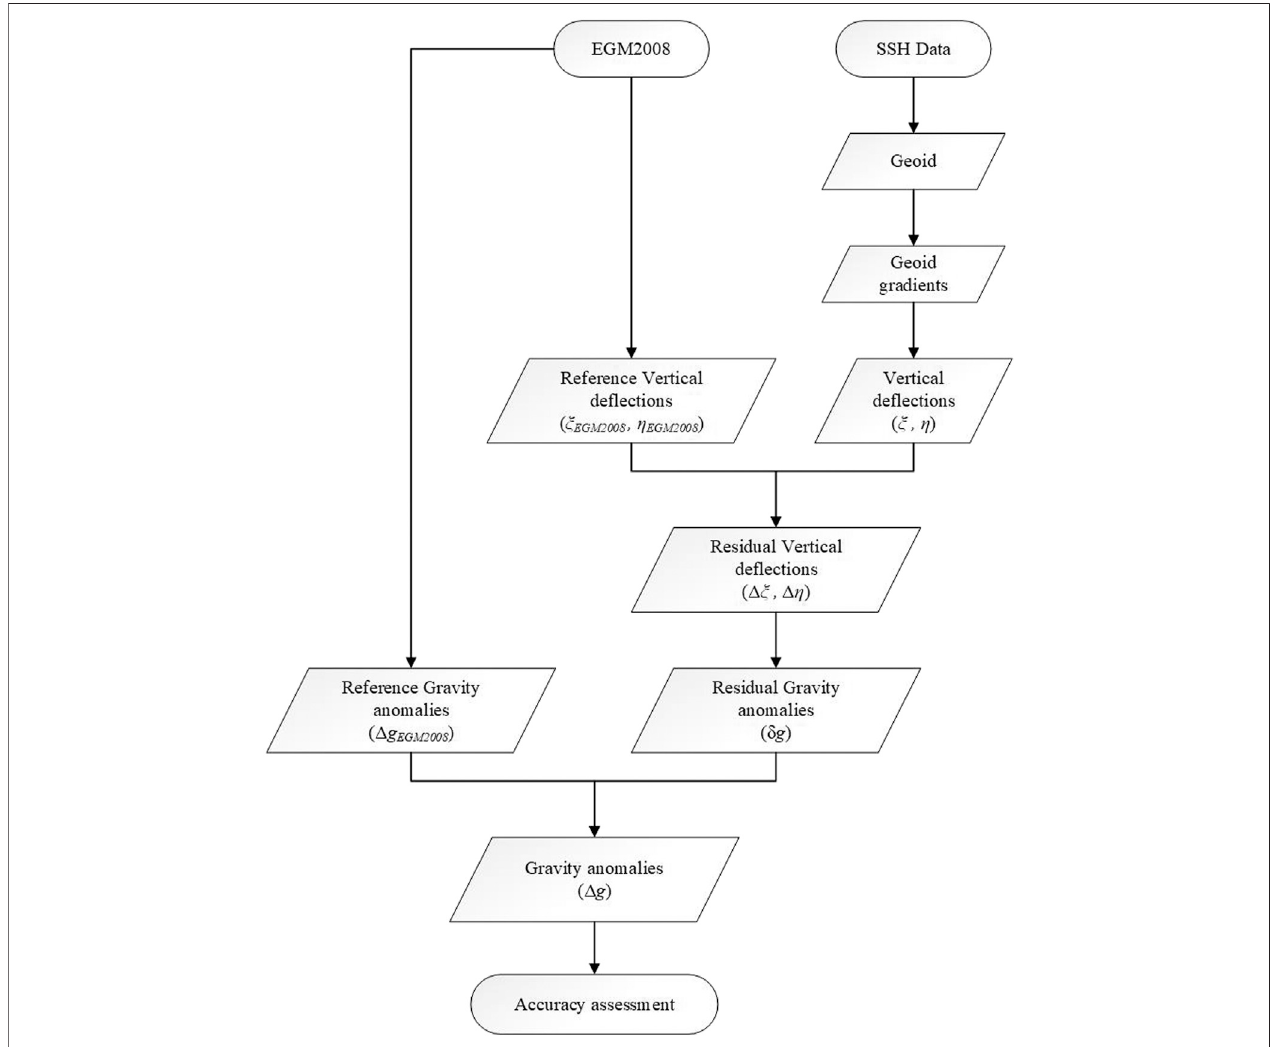
FIGURE 2 | Remove-restore technique